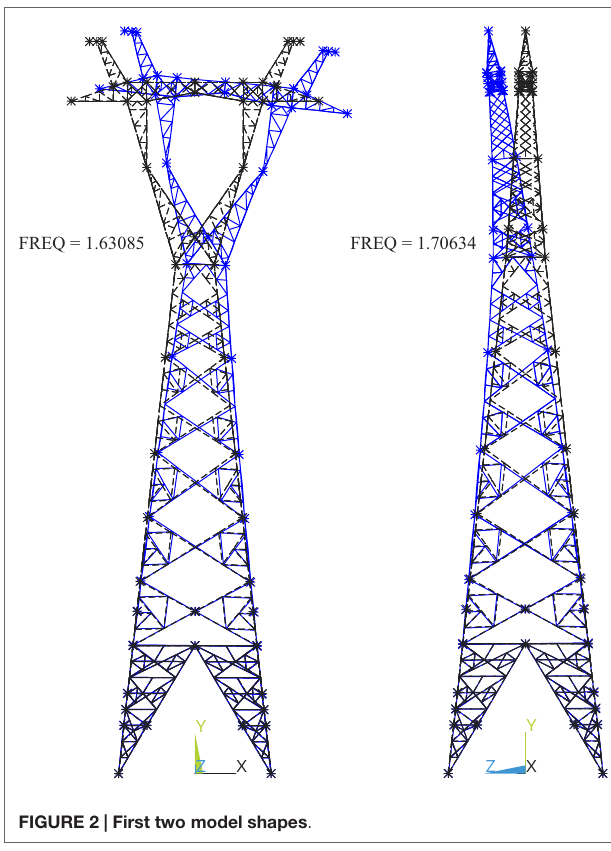
FigUre 2 | First two model shapes .